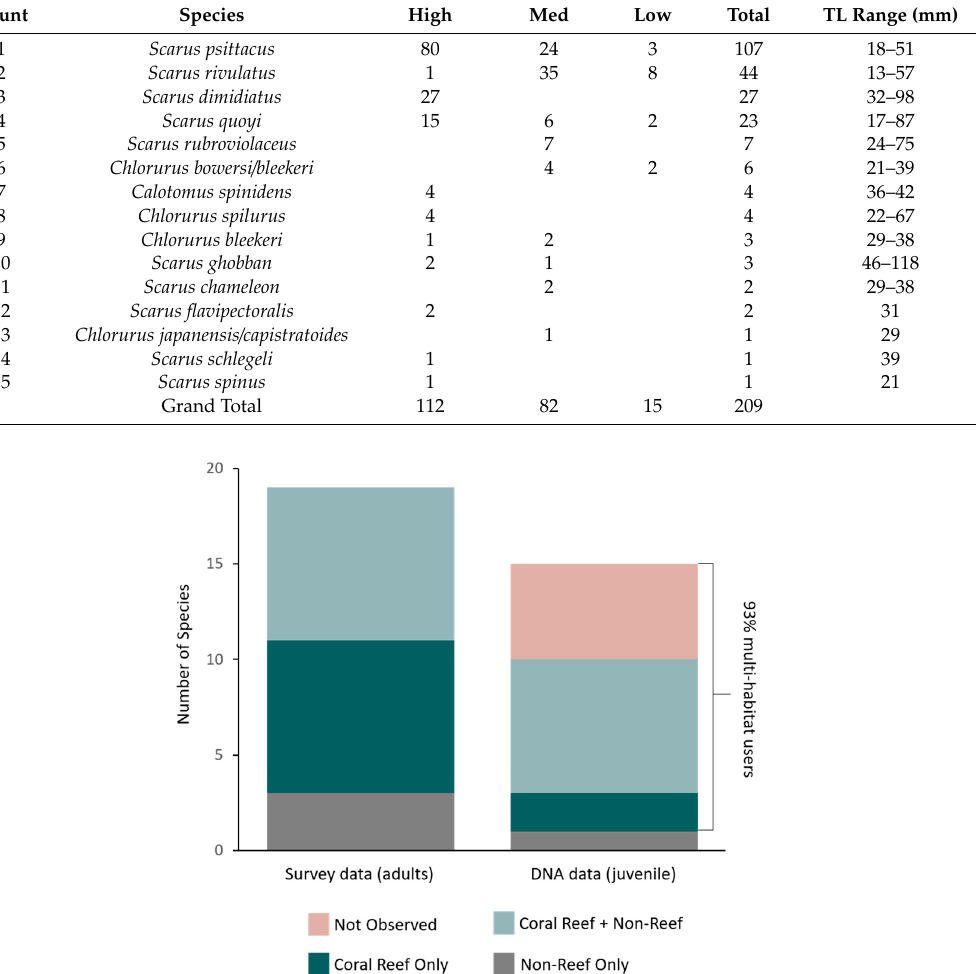
Figure 2. Habitat use classification for parrotfish species: classification colours are based on observations from adult parrotfish surveys across all habitat types. Classification of adults observed on surveys ( left ) and juveniles collected in non-reef habitats ( right ): Coral Reef only (dark green) are species only observed as adults on coral reef habitat, Coral Reef + Non-Reef (light green) are species observed as adults on both coral reef and any non-reef habitat, Non-Reef only (grey) are adults observed only in non-reef habitats, and Not Observed (beige) are species identified with DNA analysis from juvenile collections in non-reef habitats but not seen as adults on visual surveys in any